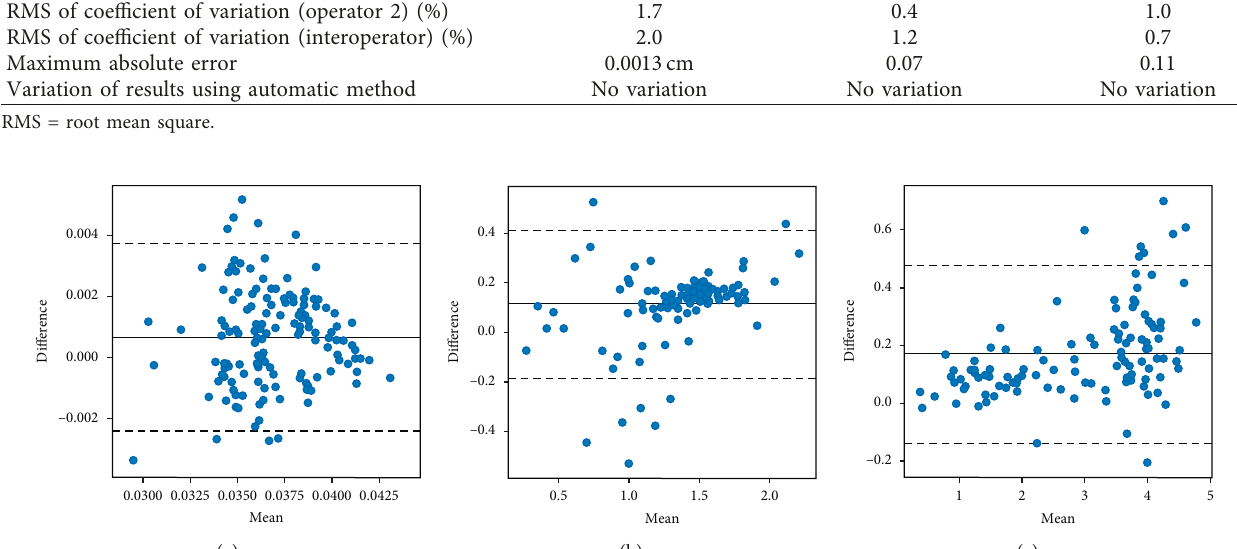
Figure 8: The Bland–Altman plot of the human bone spectra (manual method-automatic method values). The straight line is the mean of the differences. The dashed line is the mean of the differences plus or minus 1.96 ∗ SD, representing the limit of agreement. 92% of Crystallinity Index values, 93% of Mineral Maturity values, and 92% of Collagen Maturity values are within the dashed lines. Shifts of 0.0007cm for the Crystallinity Index, 0.11 for the Mineral Maturity, and 0.17 for the Collagen Maturity are observed.